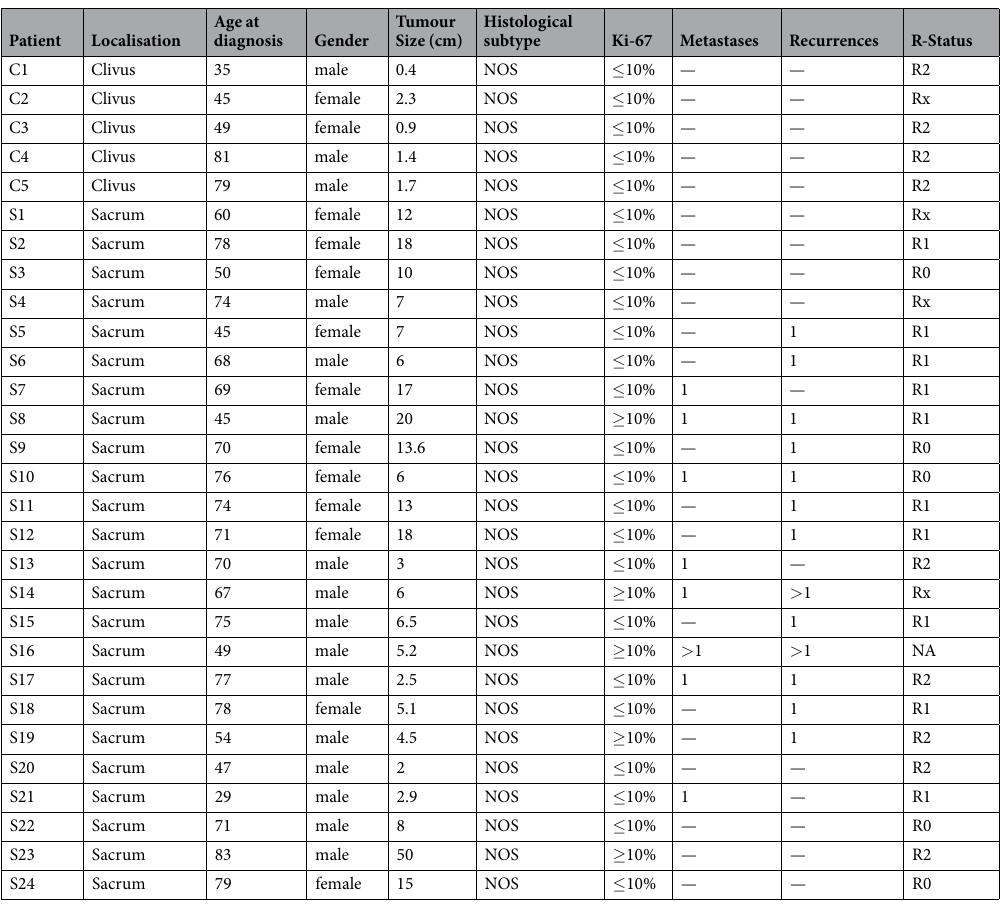
Table 1. Summarized clinical data of the clival and sacral chordoma patients. NOS not otherwise specified, R - Status residual tumour status, R0 no residual tumour, R1 tumour cells detected microscopically at the resection margin, R2 macroscopic detectable residual tumour, Rx R-status